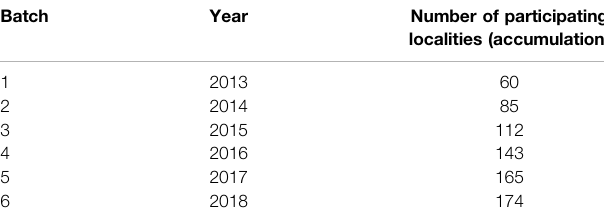
TABLE 2 | Number of participating localities of P2KH.